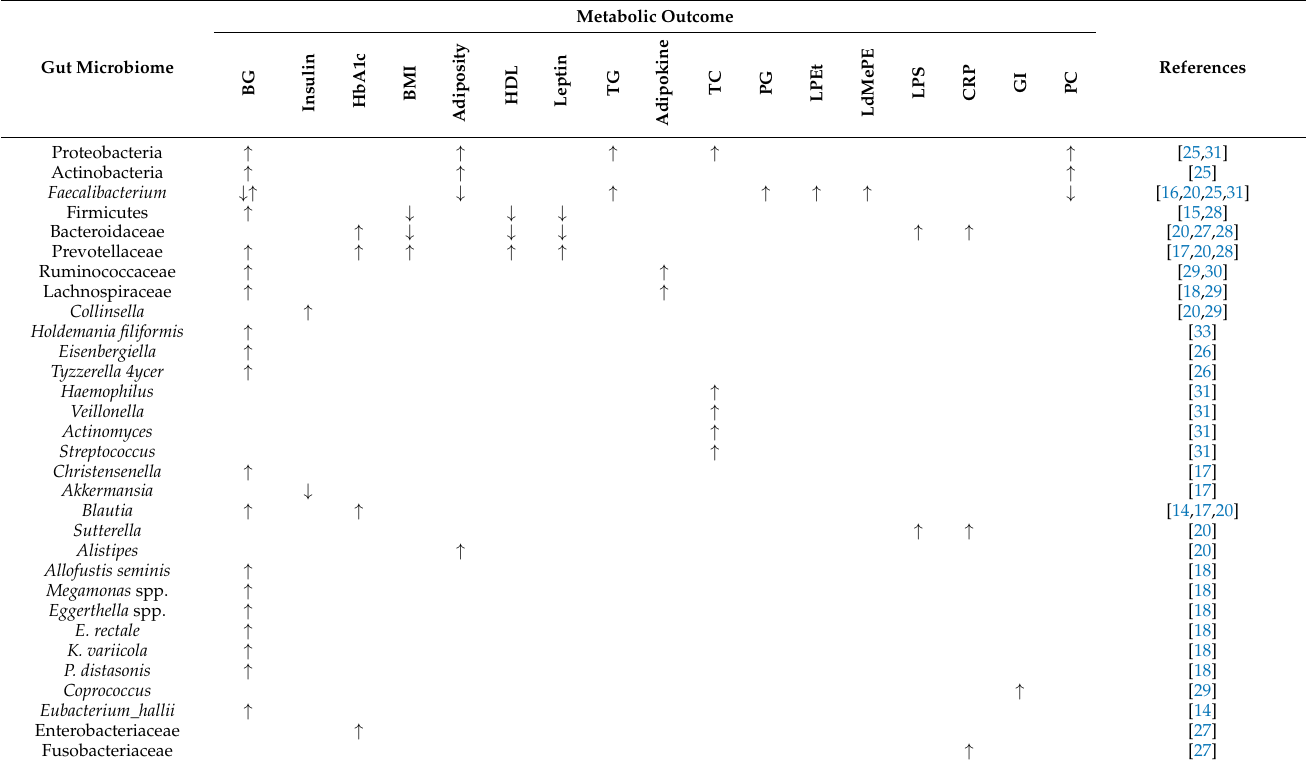
Table 2. Types of gut microbiota and their impact on the metabolic variables in